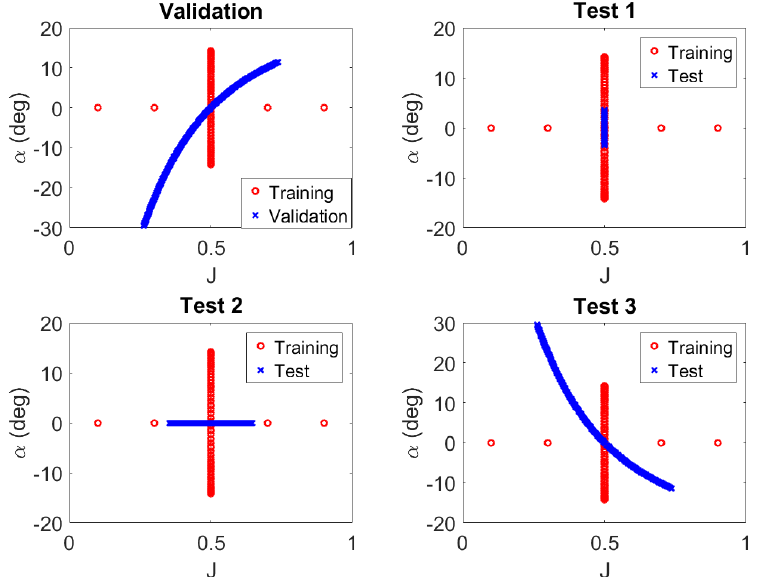
Figure 11. α -J space for training, validation, and test